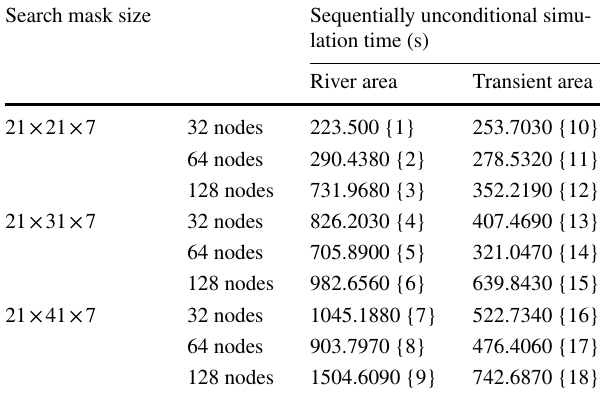
Table 3 Unconditional simulation time with different sizes of